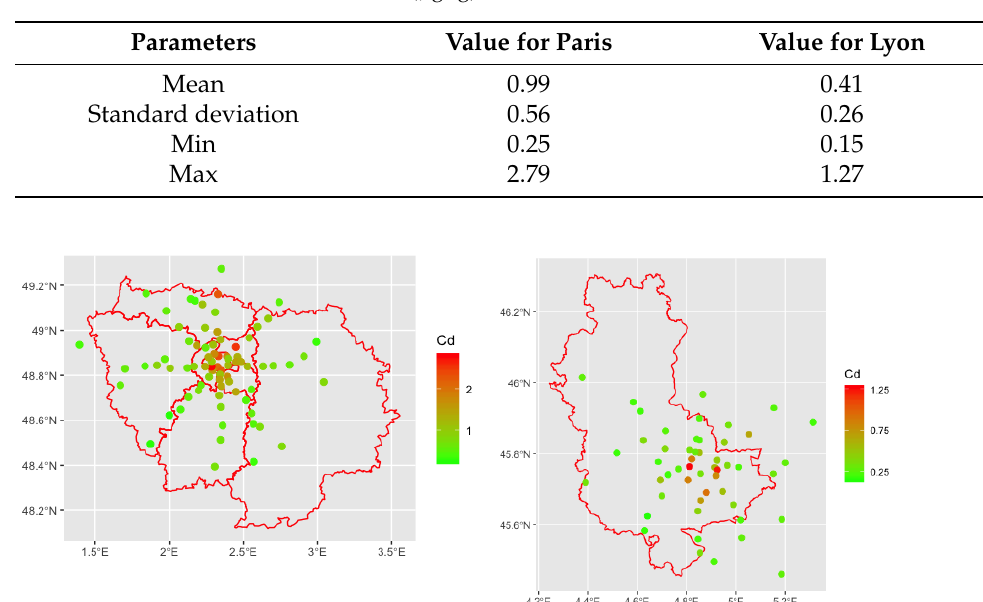
Table 1. Main statistics of Cd in mosses ( µ g/g).